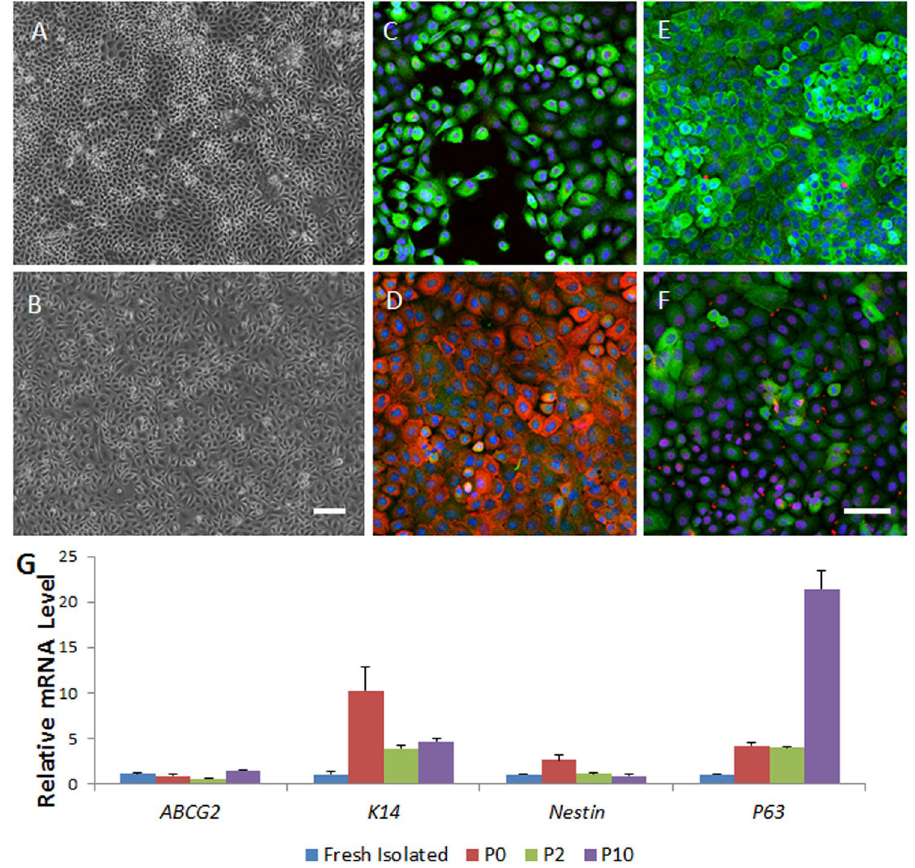
Figure 7. The proliferative capability and characterization of the immature lacrimal gland epithelial cells in monolayer cultured in serum-free media. Monolayer culture of cells from day 7 samples after duct ligature release can form a compactly organized epithelial morphology from passage 0 (P0, A ) to P12 ( B ). Immunostaining showed most of the cells to be nestin positive (green, C ), ∆ Np63 positive (red, C , F ), ABCG2 positive (red, D ), PCK positive (green, D ) and K15 positive (green, E). Some of these P10 cells to be K14 positive (green, F ), RT-qPCR showed the mRNA level of progenitor cell-related genes in the cultured cells ( G ). Bar represents 100 μ